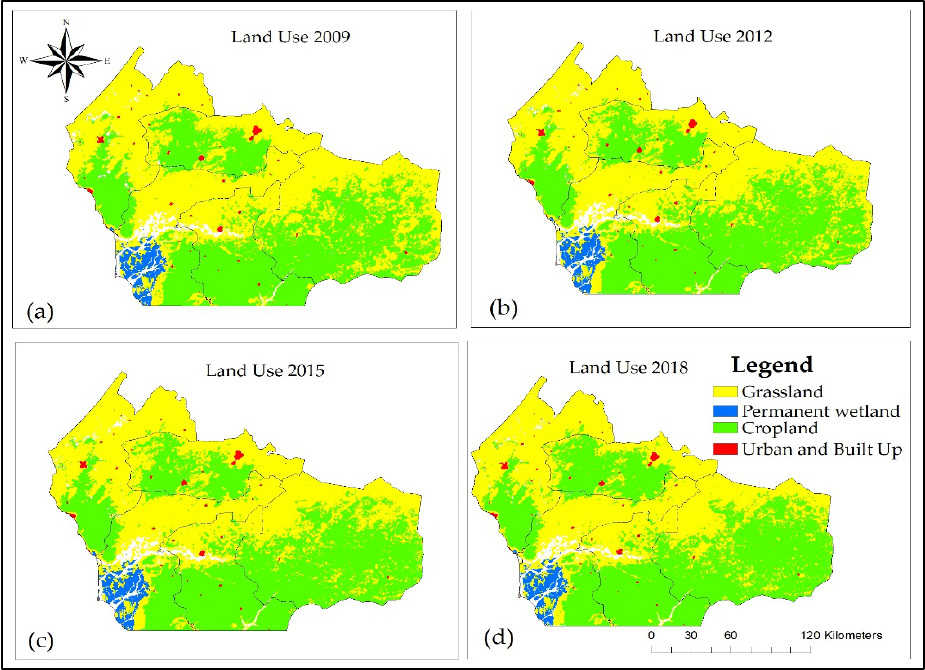
Figure 2. (a–d) show land use evolution patterns in years of 2009, 2012, 2015, and 2018 in the study area. Table 2. The statistics of the land-use area in years 2009, 2012, 2015 and 2018 (km 2 ). Land Use Pattern